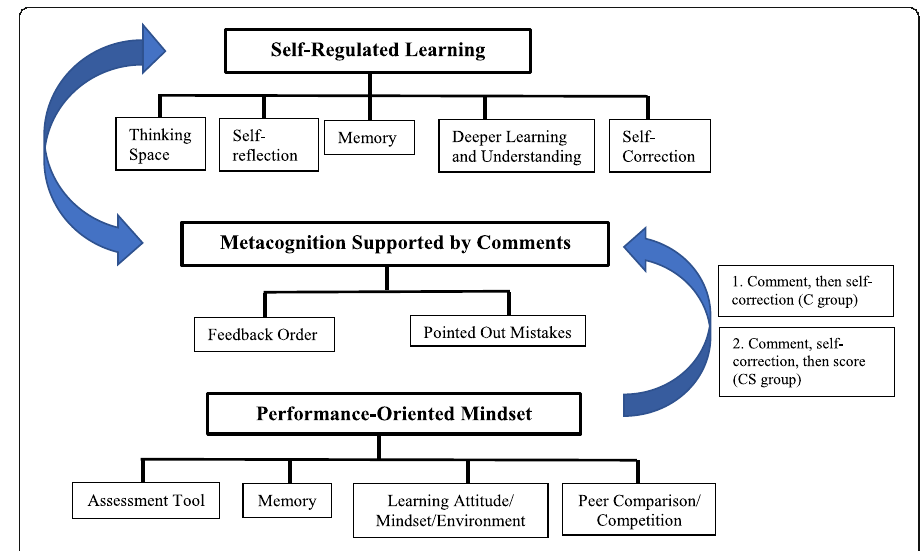
Fig. 1 Mind map for chemistry and